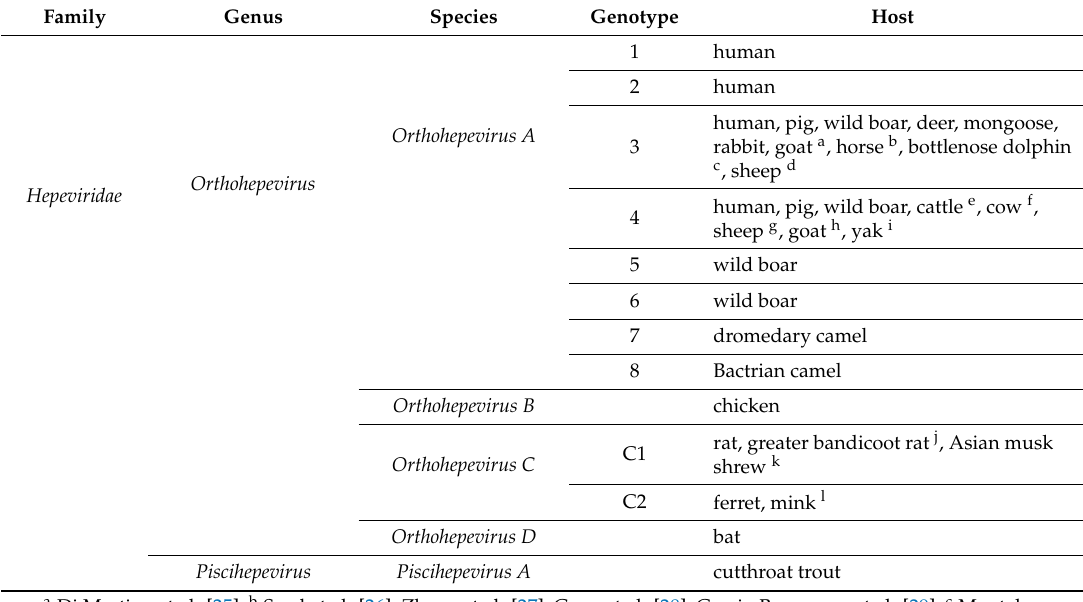
Table 1. Classification of